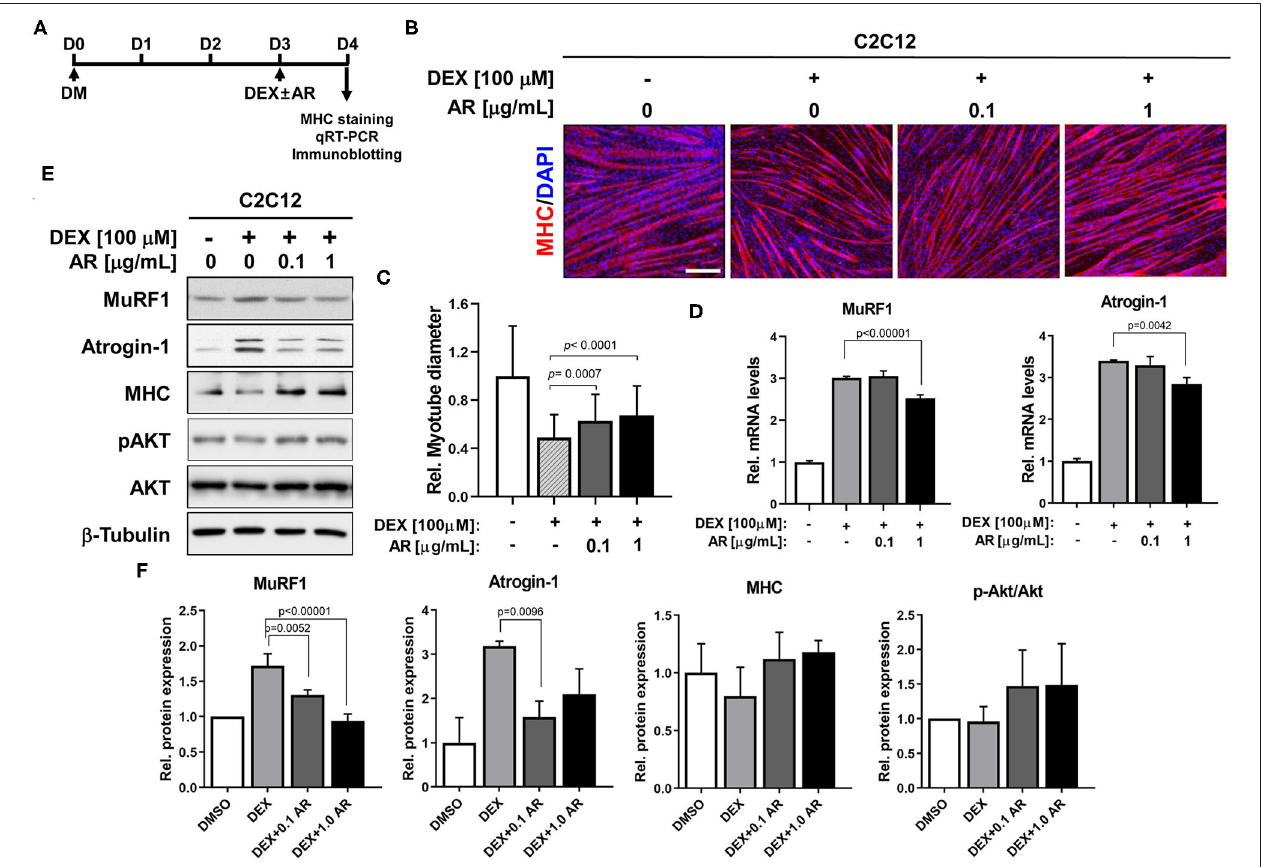
FIGURE 2 | AR prevents DEX-induced muscle atrophy. (A) The procedure diagram for atrophy study. (B) Immunostaining for MHC expression (red) and DAPI (blue) staining to visualize nuclei. C2C12 myoblasts were induced to differentiate for 3 days in DM and treated with vehicle DMSO or indicated concentration of AR with DEX. Scale bar, 60 µ m. (C) The relative diameter for panel B was quantified to show effect of AR from DEX-induced muscle atrophy. N = 123 myotubes/each sample. (D) qRT-PCR analysis for expression of MuRF1 and Atrogin-1 in C2C12 cells of the vehicle or DEX-treated AR. (E) Immunoblot analysis of C2C12 cells for the expression of MHC, MuRF1, Atrogin-1, pAkt and Akt, and β -tubulin as a loading control treated with vehicle or DEX-treated AR for D3. (F) Quantification of blots from three experiments similarly performed as shown in panel E. The signal intensity of MuRF1, Atrogin-1, and MHC was quantified, and the values were normalized to β -tubulin. The signal intensity of pAkt was quantified, normalized to total Akt. The one-way ANOVA analysis with Tukey test. AR, Aronia extract; DEX, dexamethasone; MHC, myosin heavy chain;